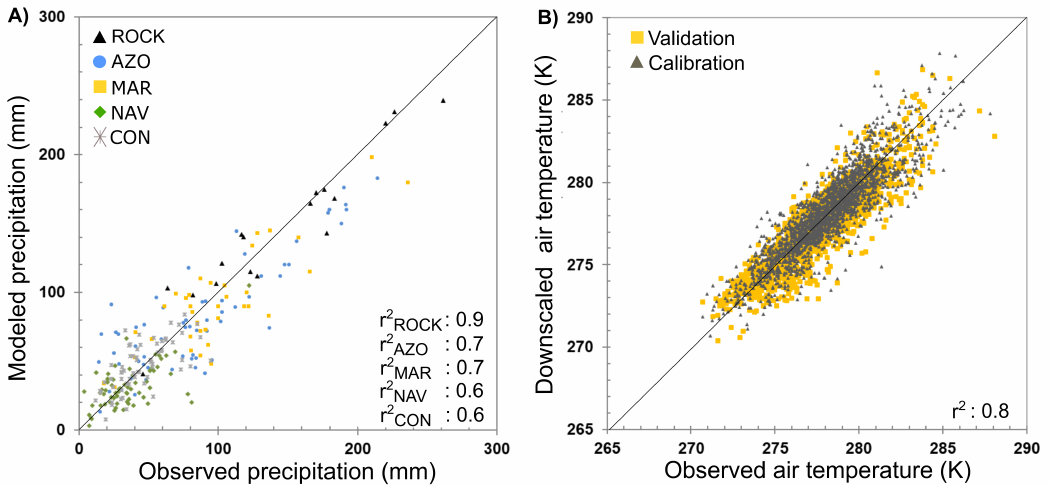
Figure 3. Downscaled ERA-interim vs. observed data for ( A ) precipitation and ( B ) air temperature. In ( A ) monthly modeled precipitation (mm) by OPM simulations and observed precipitation of the weather stations at Schiaparelli Glacier (ROCK), Rio Azopardo en Desembocadura (AZO), Marinelli Glacier (MAR), Puerto Navarino (NAV), and at Rio Condor (CON) are shown. ( B ) Observations from April 2013 to February 2015 at AWS GLACIER were used as a validation dataset and the calibration was based on observations between October 2015 and April